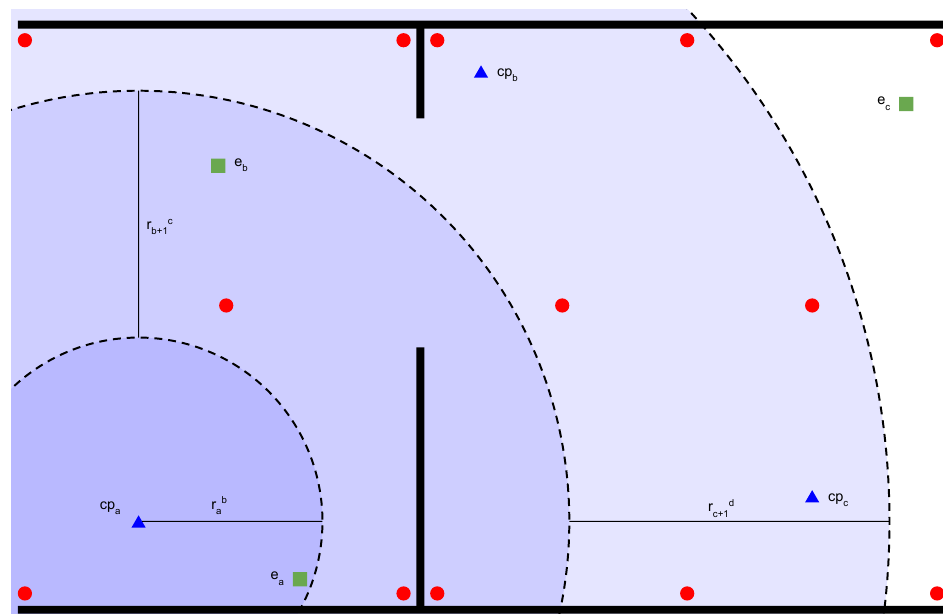
Figure 3. Example of possible